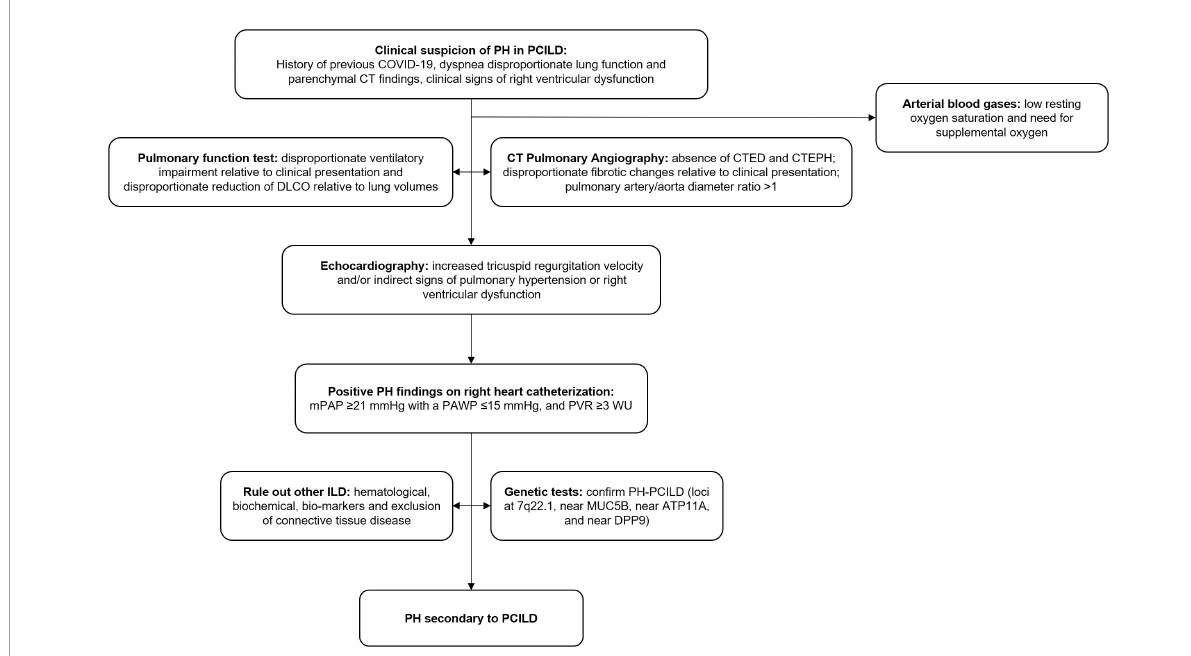
FIGURE2 Proposed algorithm for the diagnosis of pulmonary hypertension in PCILD. PH, pulmonary hypertension; PCILD, post-COVID-19 interstitial lung disease; CT, computed tomography; DLCO, diffusion capacity for carbon monoxide; CTED, chronic thromboembolic disease; CTEPH, chronic thromboembolic pulmonary hypertension; mPAP, mean pulmonary arterial pressure; PAWP, pulmonary arterial wedge pressure; PVR, pulmonary vascular resistance; ILD, interstitial lung disease.